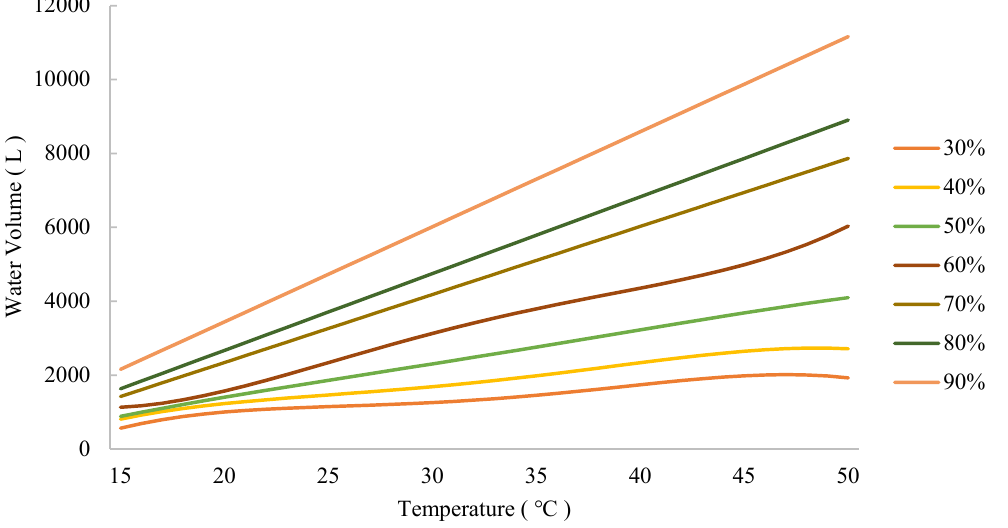
Figure 5. Interpolated harvesting profile of AWGs at specific RH profiles. Ambient temperature and relative humidity detected by the on-board hygrometric sensor of AWGs were read from the human–machine interface and recorded hourly. The volumetric flow of water generated by each AWG was respectively measured by a posi- tive displacement meter. This was recorded hourly. The data set was collected over the span of one year 5 months, between December 2019 and May 2021. The data can be cate-